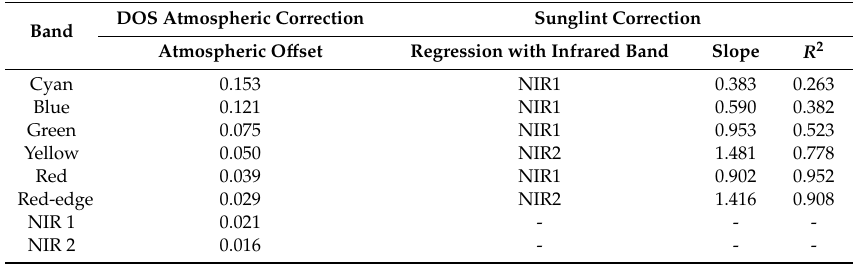
Table 2. Summary of the atmospheric o ff set for DOS atmospheric correction and regression analysis for sunglint